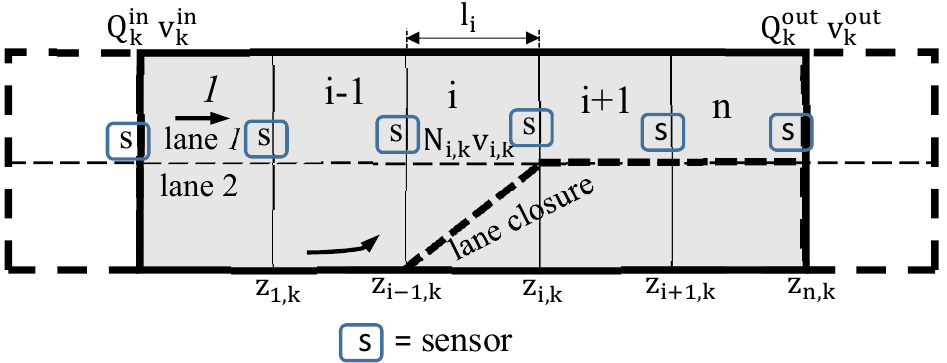
Figure 1. Stochastic compositional model (SCM) road network showing segments and measurement points